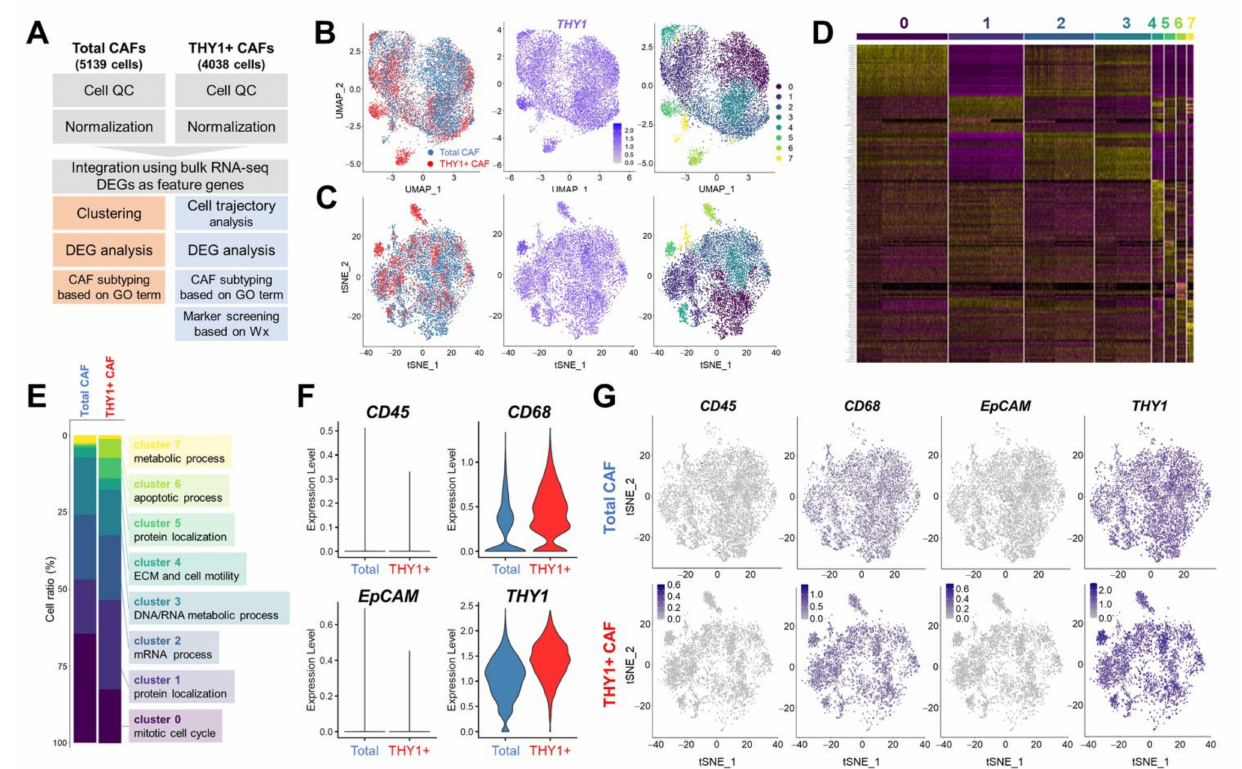
Figure 2. Single-cell RNA sequencing (scRNA-seq) of total and THY1 + CAFs. ( A ) Diagram showing the overall process from CAF isolation to scRNA-seq analysis. ( B , C ) Clustering of CAFs via the Seurat method. Data were visualized with UMAP ( B ) or t-SNE ( C ). The distribution of total and THY1 + CAFs ( left ), THY1 expression level ( middle ), and CAF subpopulations ( right ) are presented. A total of eight subpopulations were identified. ( D ) Heatmap of cluster-specific marker genes. ( E ) Gene Ontology (GO) analysis of cluster-specific marker genes. Ratios (%) of each cluster in total and THY1 + CAFs are shown in the bar chart. ( F ) Violin plots showing the expression levels of cell-type-specific markers in total and THY1 + CAFs. ( G ) t-SNE plots showing the expression patterns of cell-type-specific markers in total and THY1 +